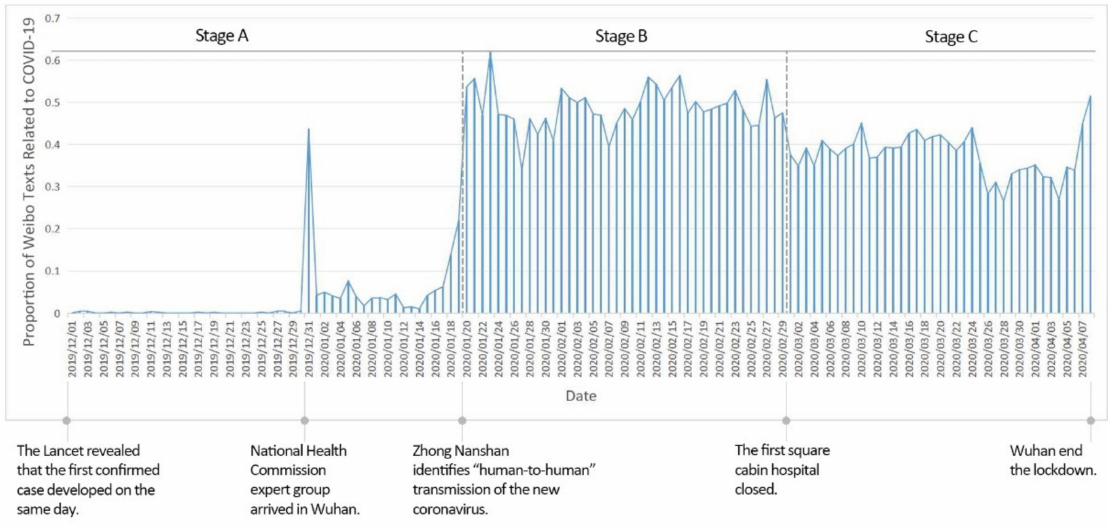
Figure 4. Trend in public attention of COVID-19-related Weibo